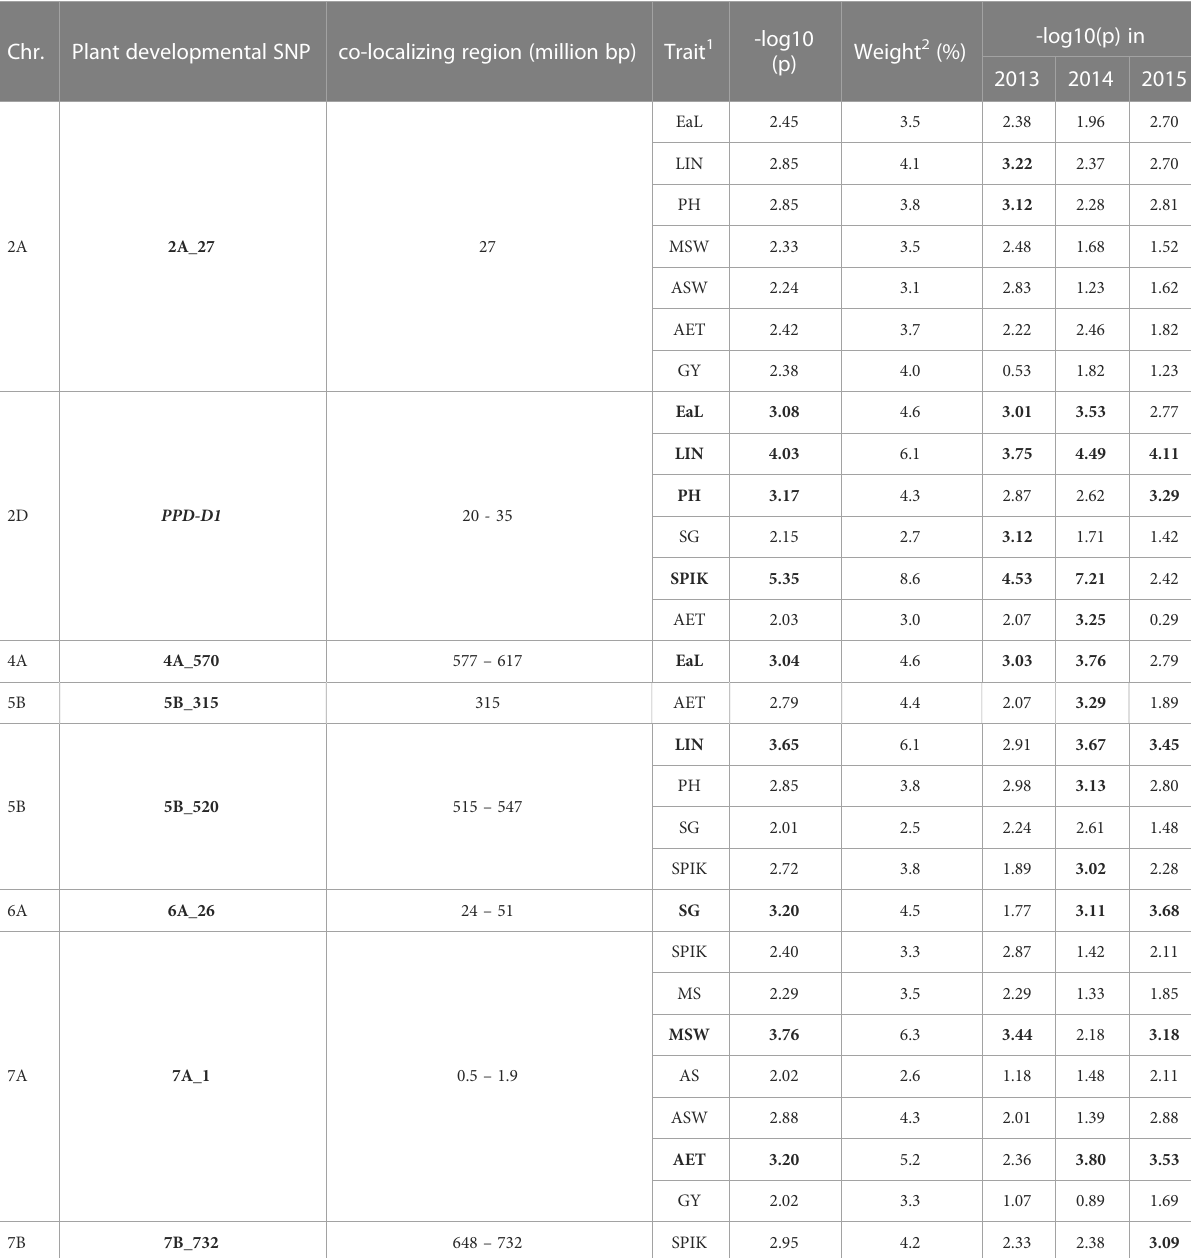
TABLE 1 Co-localizations of morphological and grain yield related marker-trait associations (MTAs) with the plant developmental loci in the group of 188 winter wheat collections.